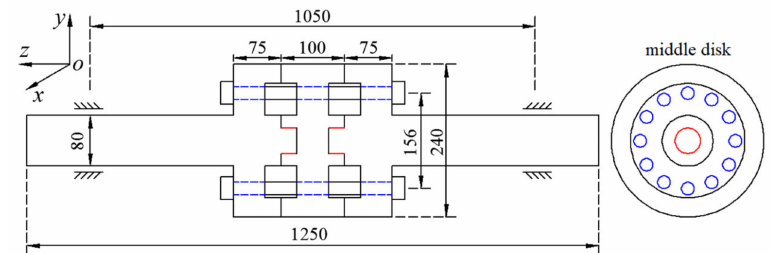
Figure 1. The structure (shaft, disks, rods, and bearings) and size (unit: mm) of rod–disk rotor bearing